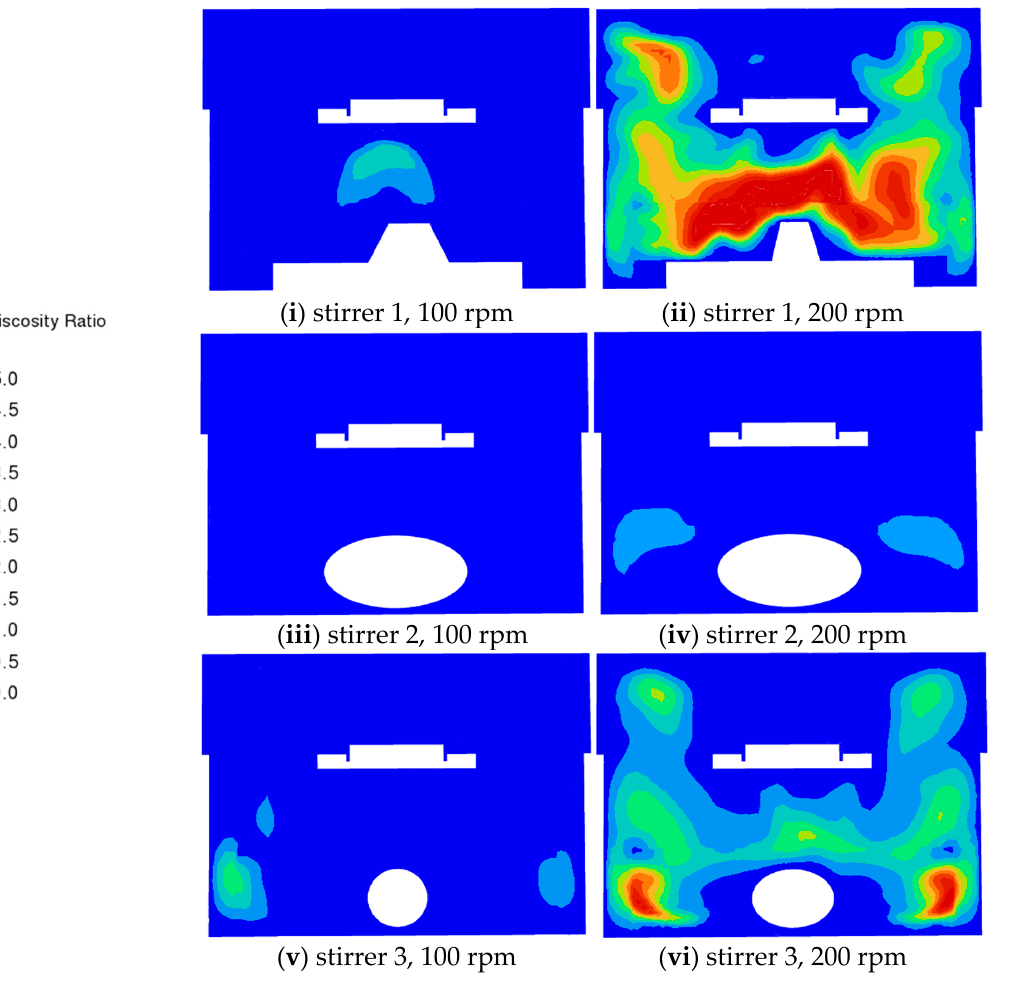
Figure 8. CFD predictions of the turbulent viscosity ratio on the vertical middle cross-section for different stirrers at different rotation speeds (100 rpm and 200